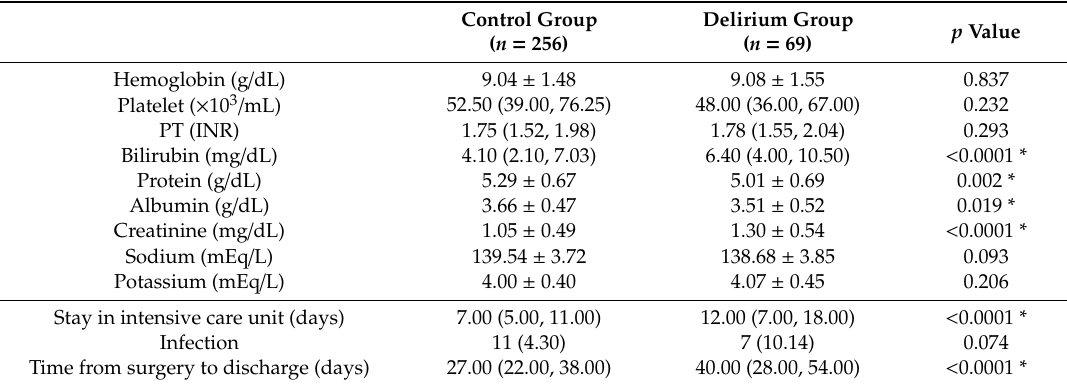
Table 4. Postoperative data in patients undergoing liver transplantation.